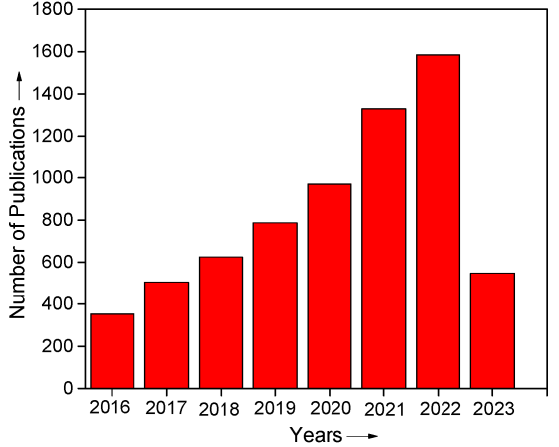
Figure 1. Trend in year-wise publications in the field of graphene-based nanocomposites.